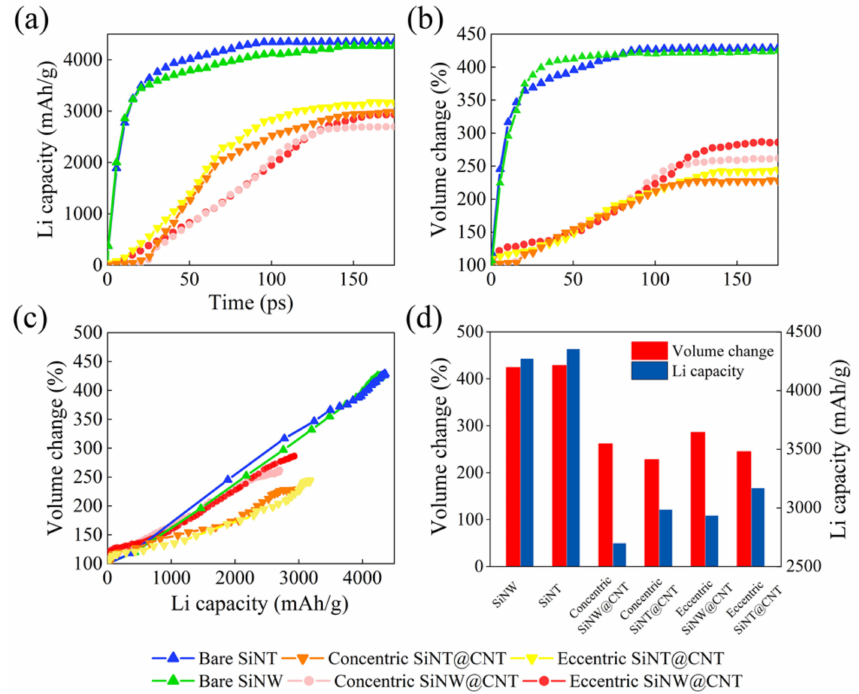
Figure 4. Lithiation performances of SiNT, silicon nanowires (SiNW), and their carbon nanotube (CNT)-coated nanohybrids. ( a ) Li capacity with lithiation time, ( b ) Volume change with lithiation time, ( c ) Volume change versus Li capacity during lithiation, and ( d ) Volume change and Li capacity of the final lithiated